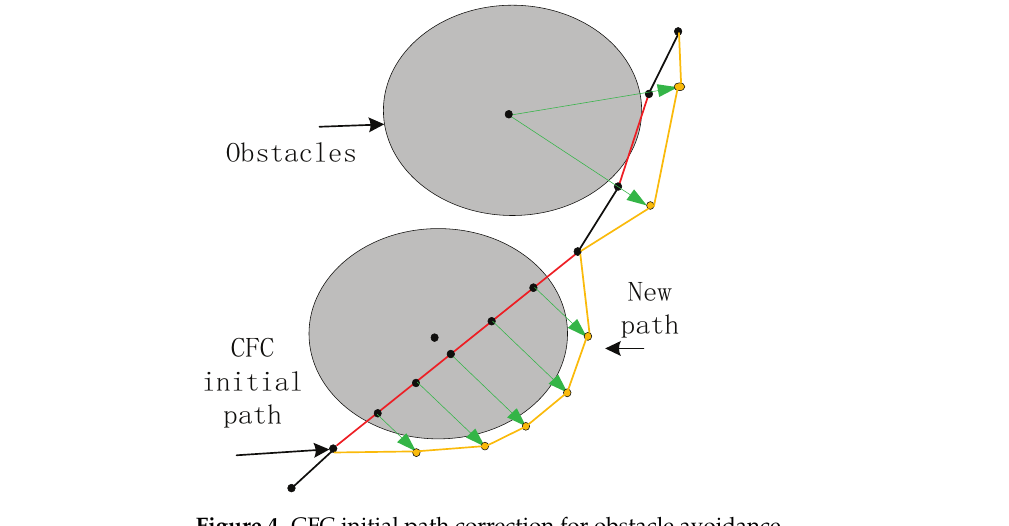
Figure 4. CFC initial path correction for obstacle avoidance. Algorithm 3: For a given initial CFC path p initCFC , the position of obstacles p m , the safe distance r safe , and step factor λ to find the initial global obstacle avoidance discrete